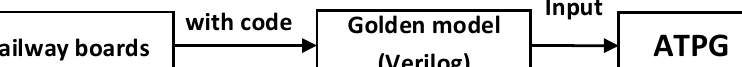
Figure 4. Pseudorandom patterns generate curve of the fault coverage varying with n and the algorithm switching point.